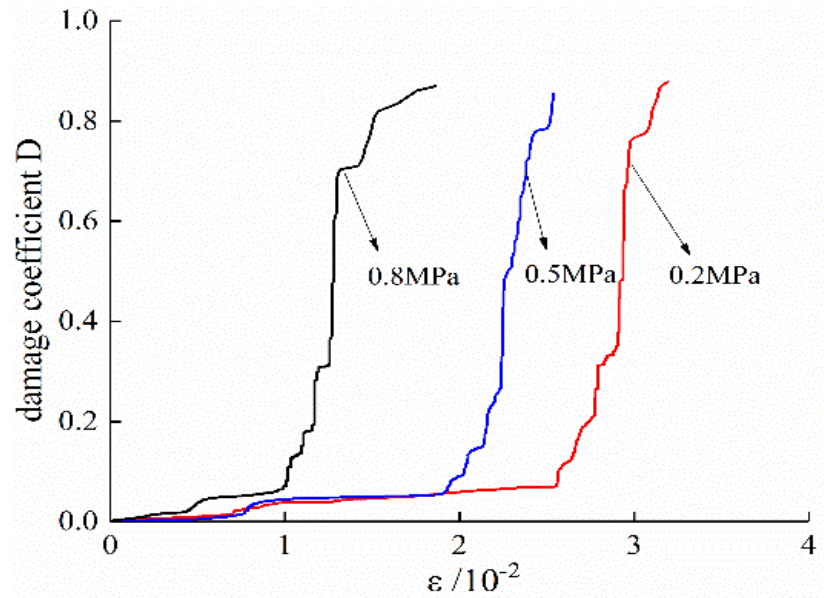
Figure 10. Unloading test damage coefficient D.